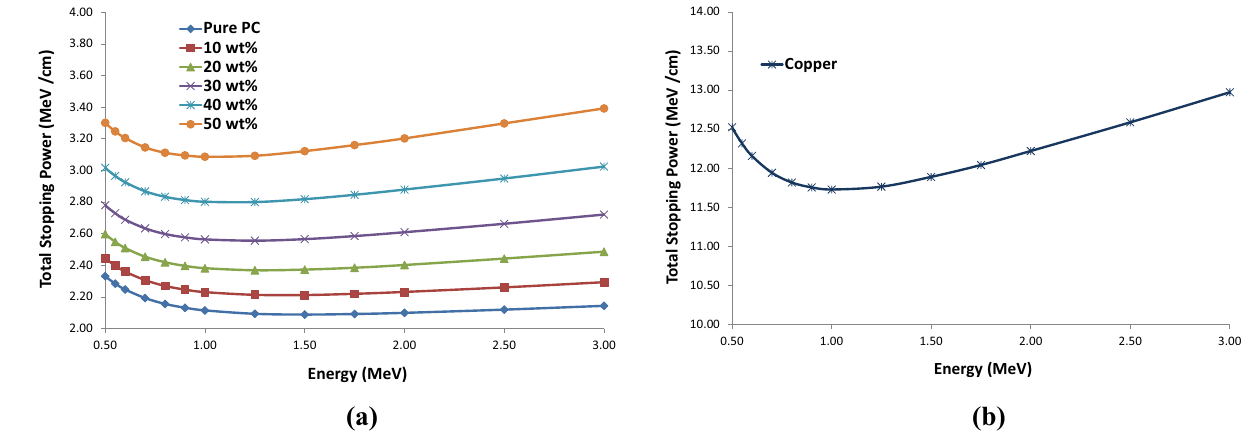
Figure 6. The total stopping power of electrons at different energies up to 3 MeV for ( a ) various weight percentages of the PC–Bi 2 O 3 composite and ( b ) copper, using the ESTAR program.